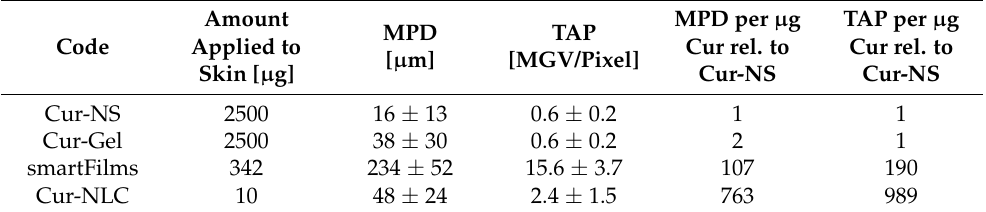
Table 5. Comparison of applied curcumin dose and dermal penetration efficacy of curcumin from different